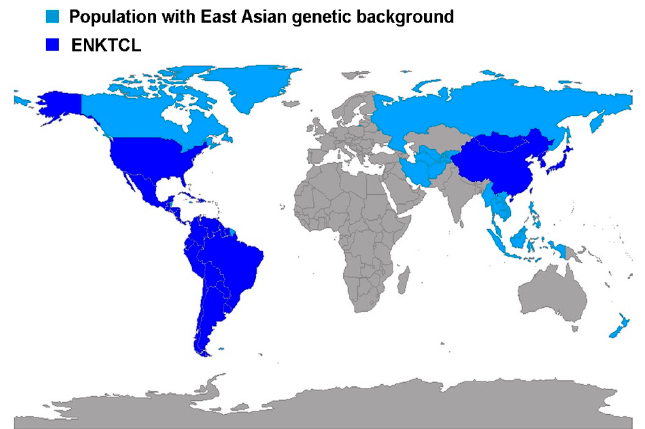
Figure 1. Map illustrating the worldwide distribution of extranodal NK/T cell lymphoma (ENKTCL) in countries with a population of east Asian genetic background. East Asian populations are depicted in blue; countries with high prevalence of ENKTCL are illustrated in dark blue. This map was elaborated using R version 3,6,2 with the package rworldmap